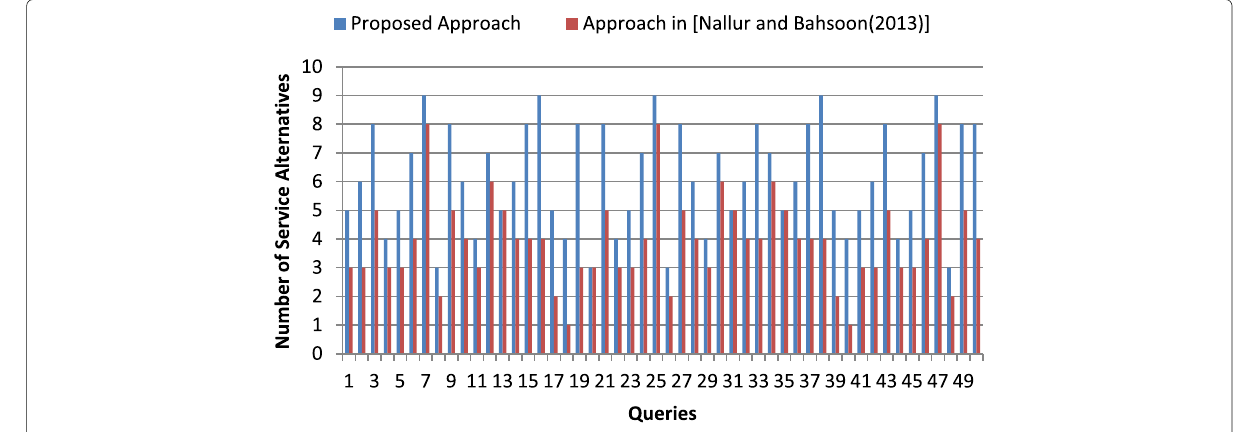
Fig. 10 Service alternatives in case of [17] and proposed approach